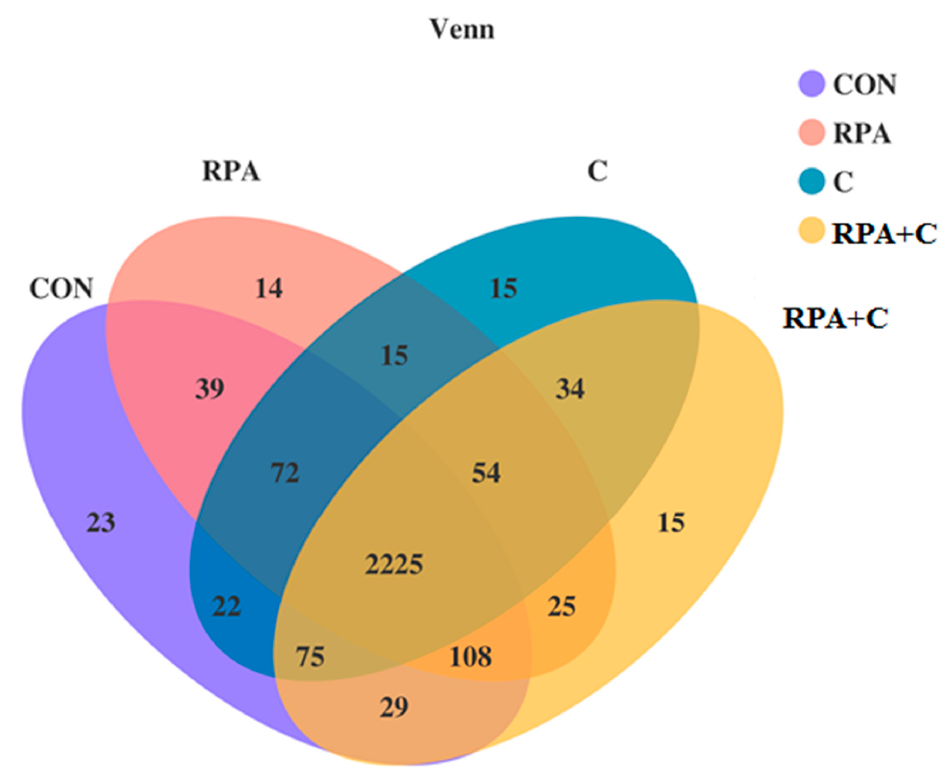
Figure 2. Venn diagram showing different and similar OTUs in yaks offered supplementary 15 g/day RP-Lys and 5 g/day RP-Met (RPA), 1.2 kg/day concentrate (C) and 15 g/day RP-Lys, 5 g/day RP-Met and 1.2 kg/day concentrate (RPA+C), or no supplements (control-CON).